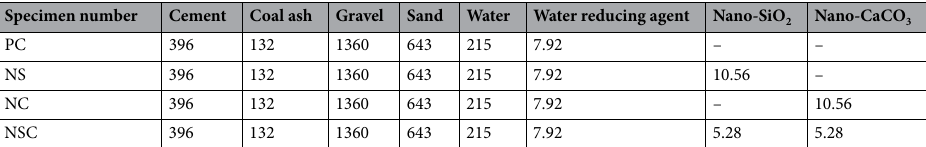
Table 5. Mix ratio of concrete (unit: kg/m 3